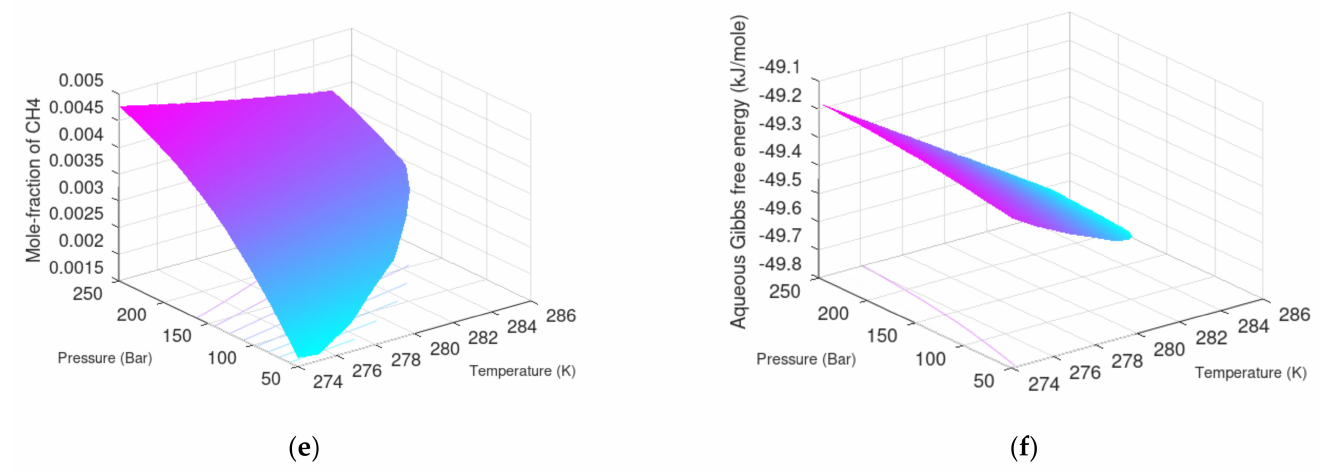
Figure 7. CH 4 solubility in water ( a , c , e ) as function of temperature and pressure and Gibbs free energy for the aqueous solution ( b , d , f ). ( a , b ) are for pure water, ( c , d ) are for water with mole-fraction